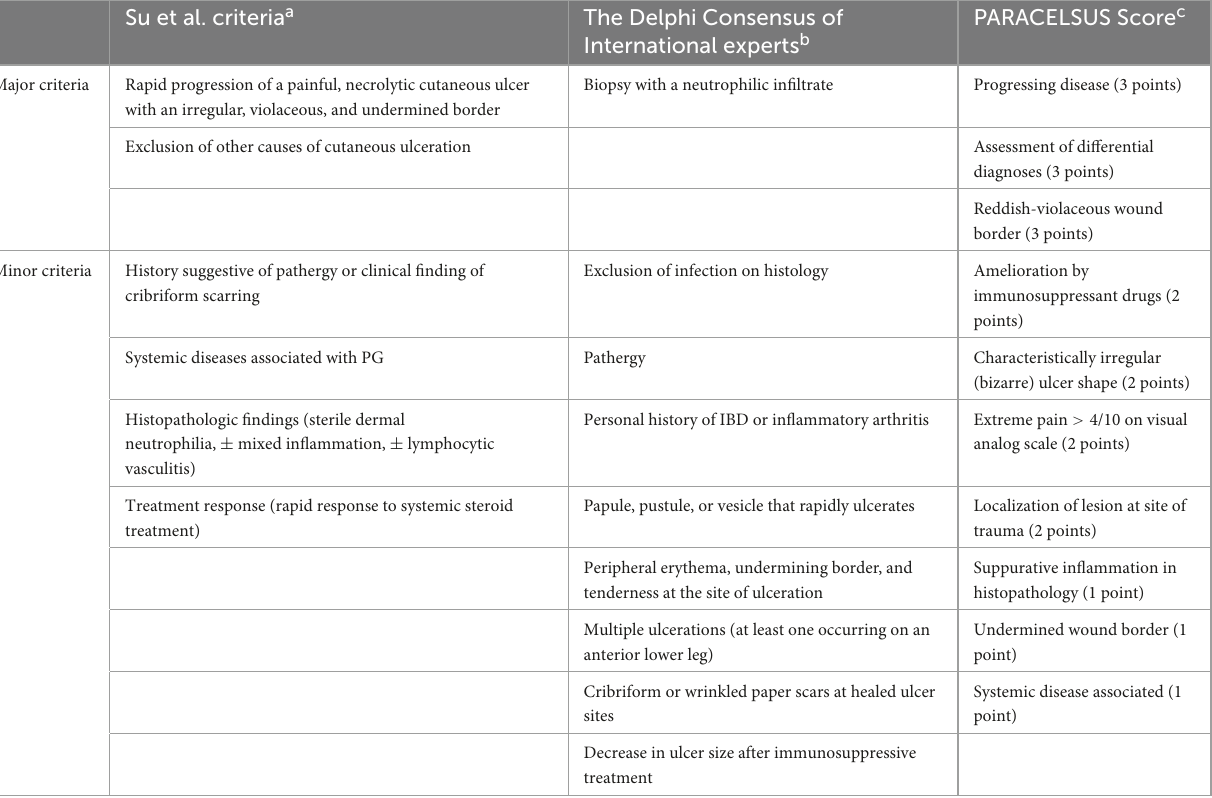
TABLE 2 Comparison of the different diagnostic criteria suggested for PG